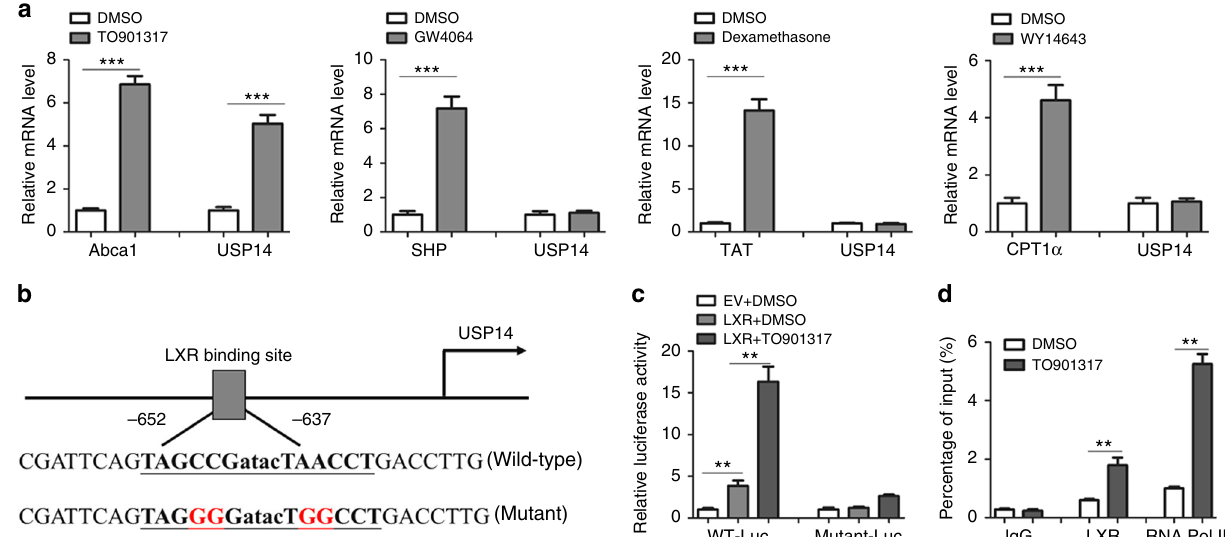
Fig. 8 Regulation of USP14 expression by LXR. a Relative mRNA levels of USP14 in MPHs treated with TO901317, GW4064, dexamethasone, WY14643 or vehicle control (DMSO) for 16 h. Expression of Abca1, SHP, TAT, and CPT1 were used as positive controls for LXR, FXR, GR, and PPAR activation, respectively. b Proximal promoter region of mouse USP14 gene contains a potential binding site for LXR. c Luciferase reporter assays. HEK293T cells were transfected with luciferase reporter plasmids containing wild-type (WT-Luc) or mutant (Mut-Luc) binding site of LXR. Cells were treated with vehicle control (DMSO) or TO901317 for 12 h. d Chromatin immunoprecipitation assays showing representative LXR and RNA Pol II binding to the USP14 promoter in MPHs. Cells were treated with TO901317 or DMSO for 4 h and then subjected to ChIP assays. Data are presented as mean ± SEM. ** p < 0.01; *** p < 0.001 (Student ’ s t-